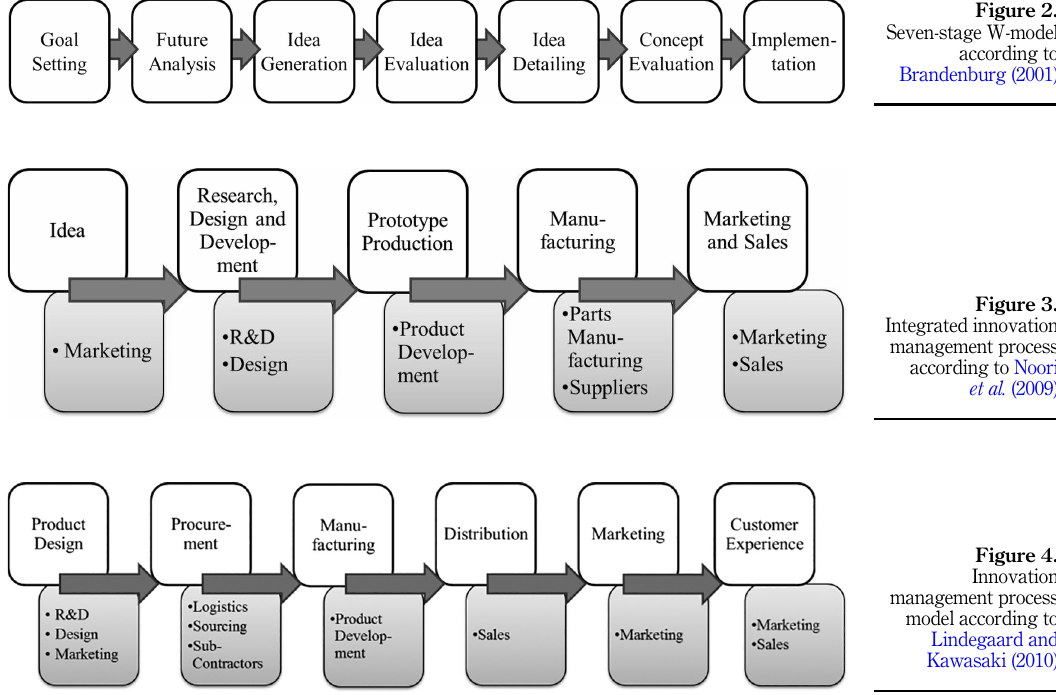
Figure 2. Seven-stage W-model